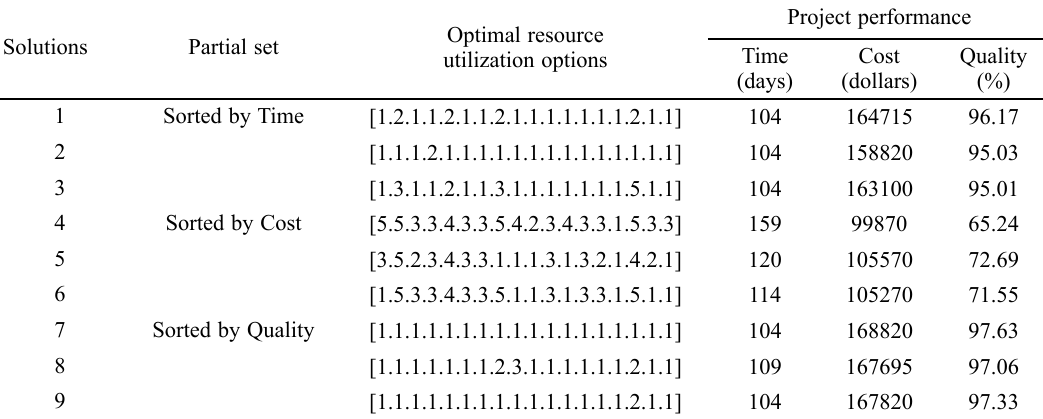
Table 3. Best non-dominated solutions obtained by CA-MODE-TCQT